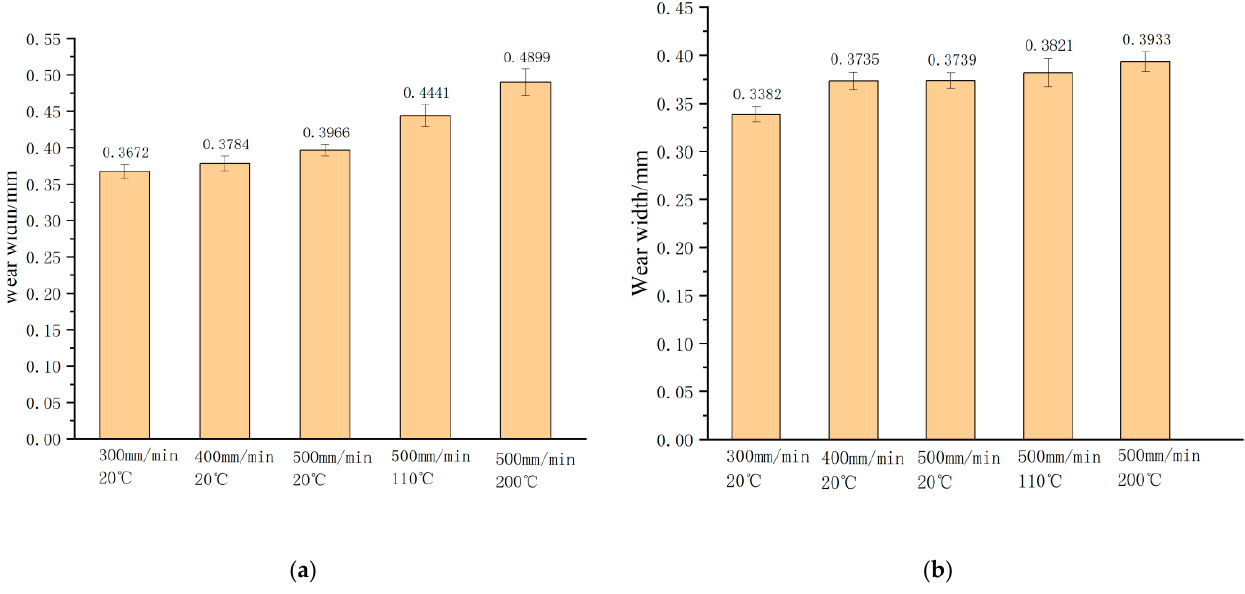
Figure 7. Wear surface width under different conditions. ( a ) Wear surface of the hardened layer after laser hardening with a scanning speed of 700 mm/min. ( b ) Wear surface of the hardened layer after laser hardening with a scanning speed of 800 mm/min.